Question: Generate an informative caption for the figure above.
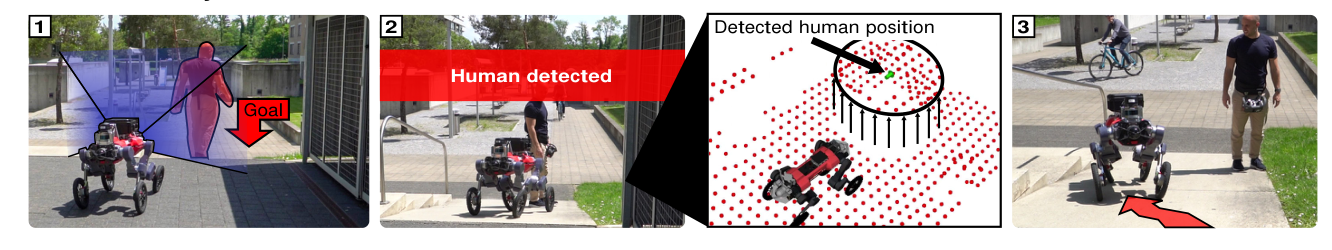
Answer: Obstacle negotiation. (A) Our robot navigates around blocked routes by actively exploring the area and finding alternative paths. (B) Safe traversal of a narrow space. (C) Our robot exhibits two different ways to traverse the complex obstacle. (C, D) Our robot shows an asym- metric understanding of traversability, being able to traverse higher steps when going down. (D) We ensure safety around humans by incorporat- ing additional human detection and overriding height scan values.